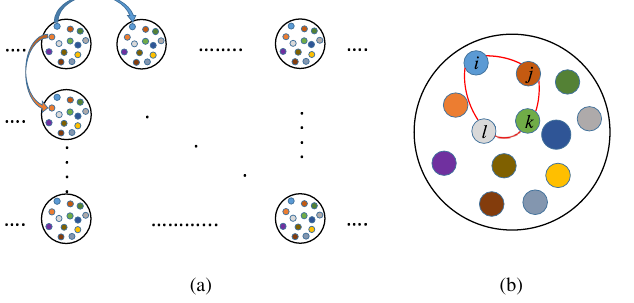
FIG. 2. The self-energy diagram Σ , index i in the single-band model due to U rr 0 represent fully dressed Green ’ s functions, G The dashed line corresponds to U 2 frequency or , are quartic in the fermion ijk l